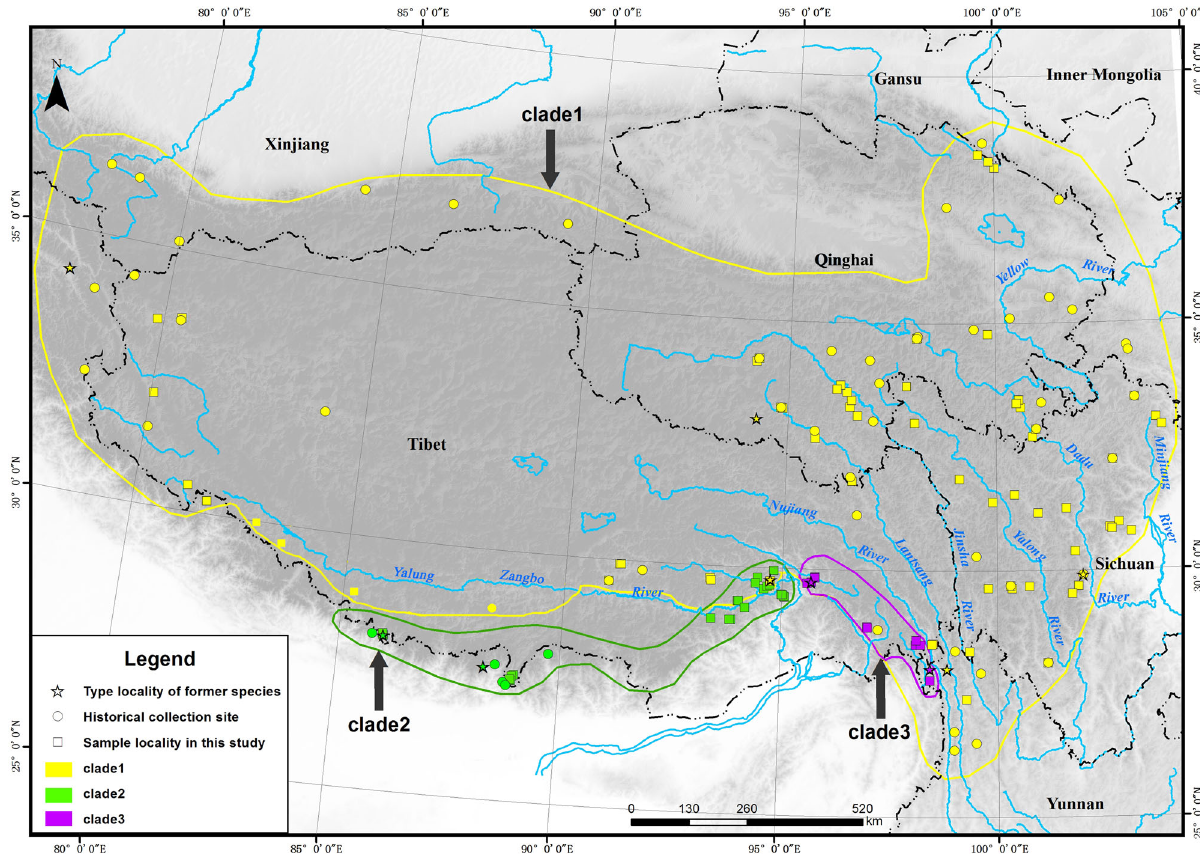
Fig. 1 Distribution of Neodon used in this study. The approximate extent of occurrence of each clade is shown with coloured lines (Clade 1: yellow; Clade 2: green, Clade 3: purple, refer to Fig. 3 for clade information). Stars show the type localities of the described species. Circles show the historical collection sites. Squares show the distribution of newly collected